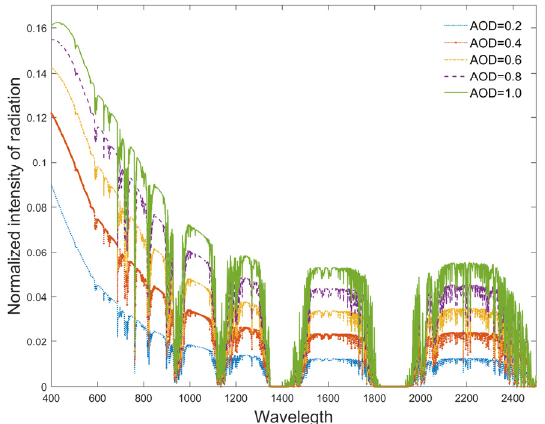
Figure 2. Forward simulation of different atmospheric aerosols by UNL-VRTM.